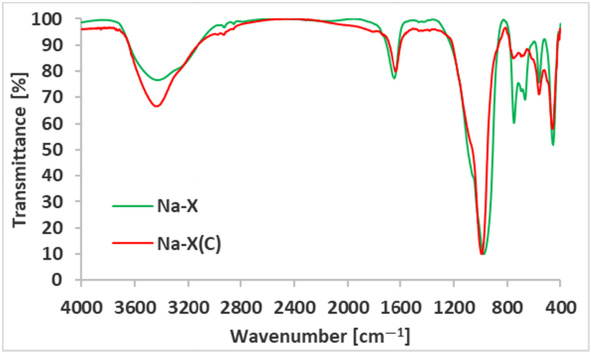
Figure 5. FTIR spectra of Na-X and Na-X(C).